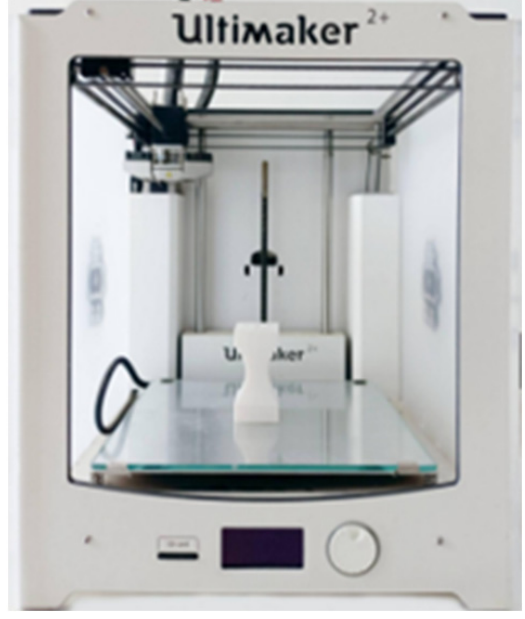
Figure 2. Ultimaker 2+ printer. Table 1. The process parameters used in printing the test specimens.